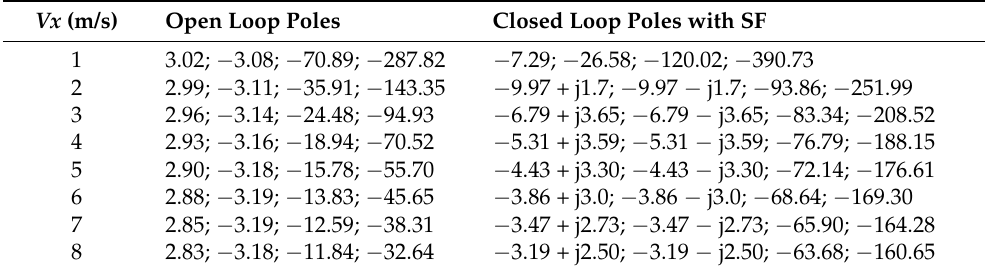
Table 1. Open loop unstable and closed loop stabilized poles of the tilting system. Vx (m/s) Open Loop Poles Closed Loop Poles with